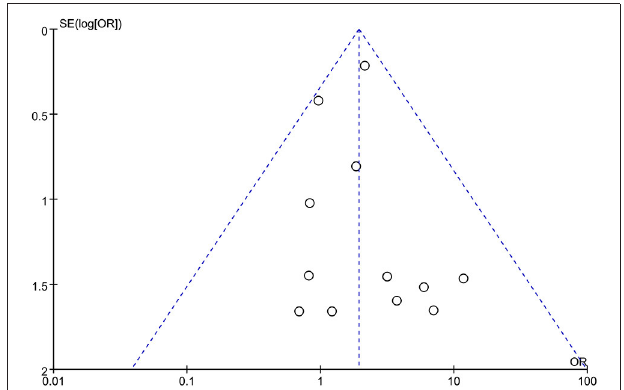
FIGURE 4 | Funnel plot for Fetal loss.